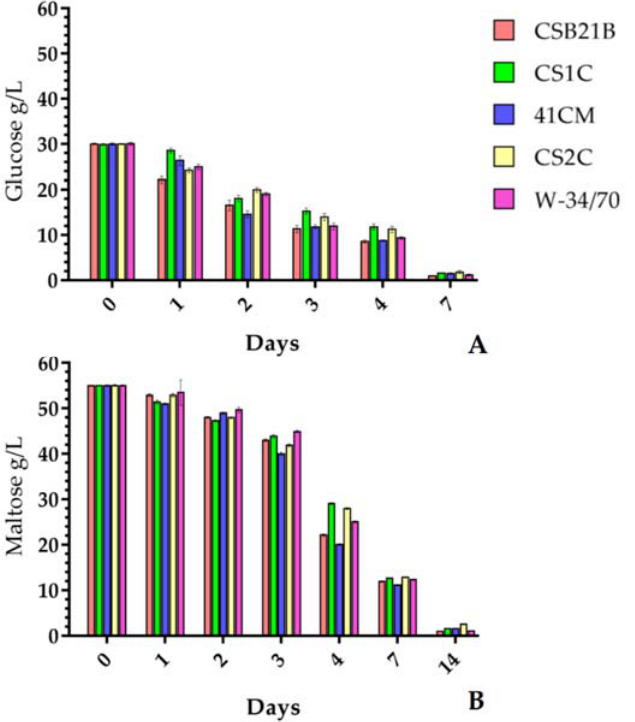
Figure 2. Fermentation kinetics of glucose ( A ) and maltose ( B ) in MBW inoculated with S. cerevisiae CSB21B, CS1C, CS2C, 41CM and S. pastorianus W ‐ 34/70.